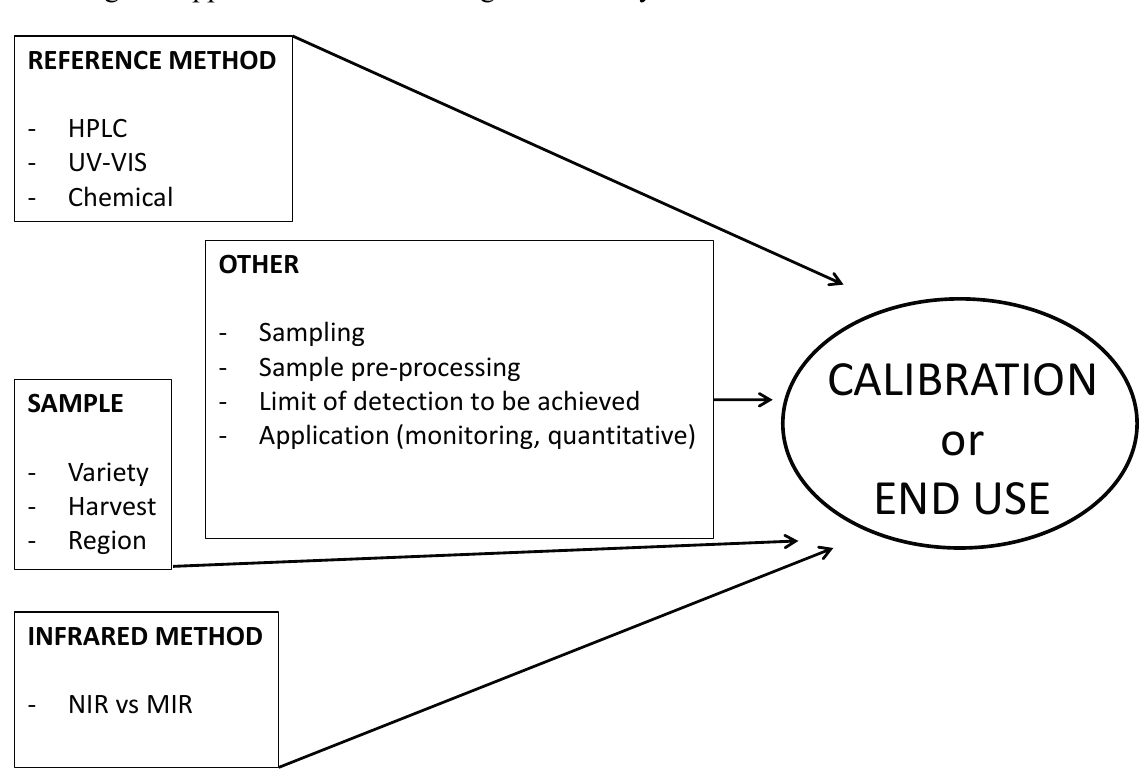
Figure 1. Factors that affect the end use of infrared methods for the analysis of phenolic compounds in grapes and wine